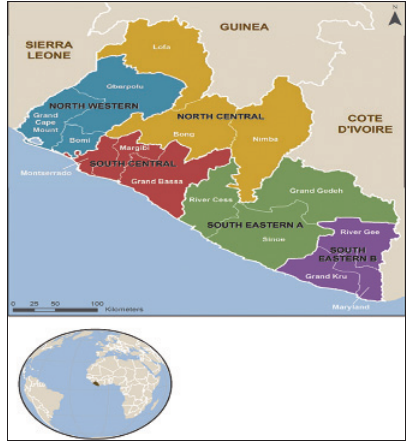
Figure 1 . Map of Liberia. Source. LISGIS. [4]